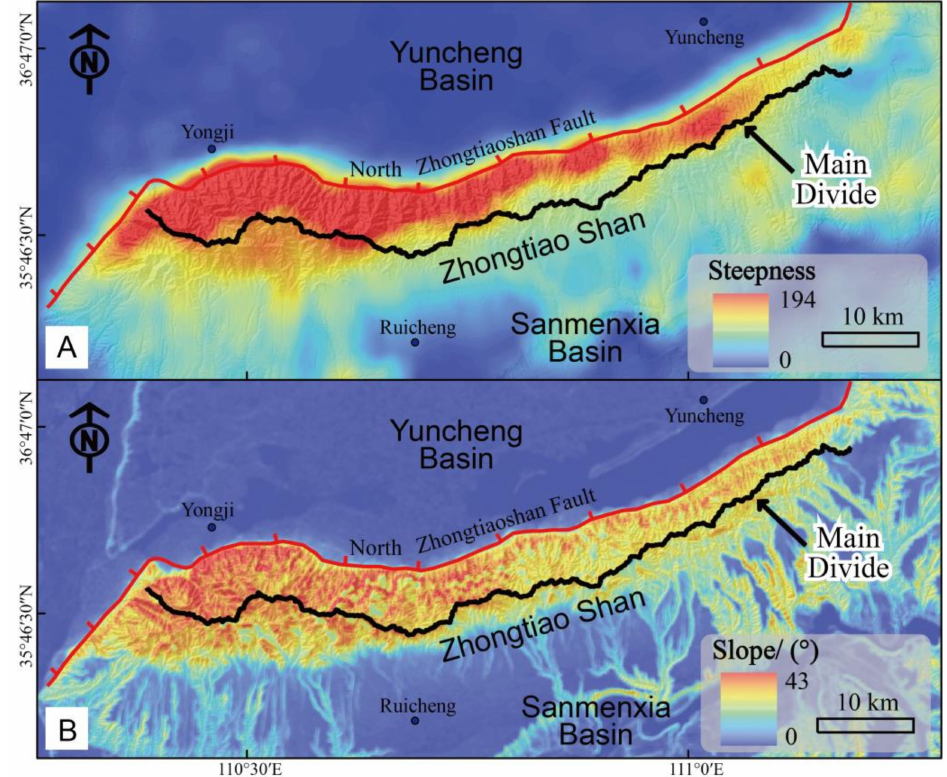
Figure 4. ( A ) Channel steepness and ( B ) slope distributions of the Zhongtiao Shan and Yuncheng Basin. Note that the slope and steepness values on north side of the Zhongtiao Shan are higher than those on south side. Moreover, in the northern sector of the main divide, metrics decrease moving from west to